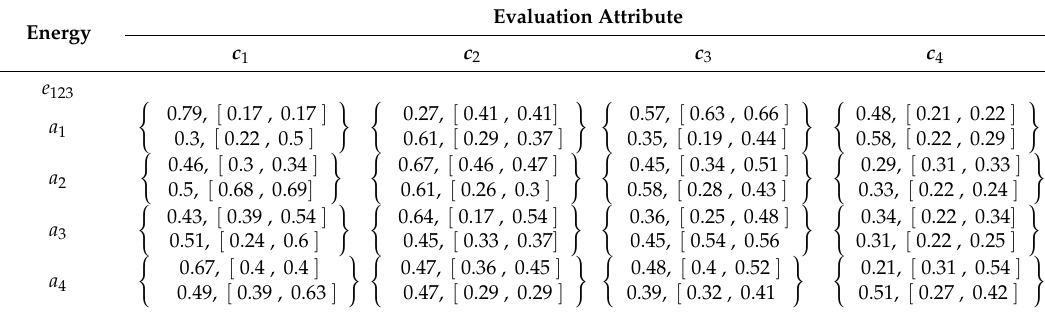
Table 3. Aggregation of preferences by using interval-valued probabilistic hesitant fuzzy Muirhead mean (IVPHFMM) operator.